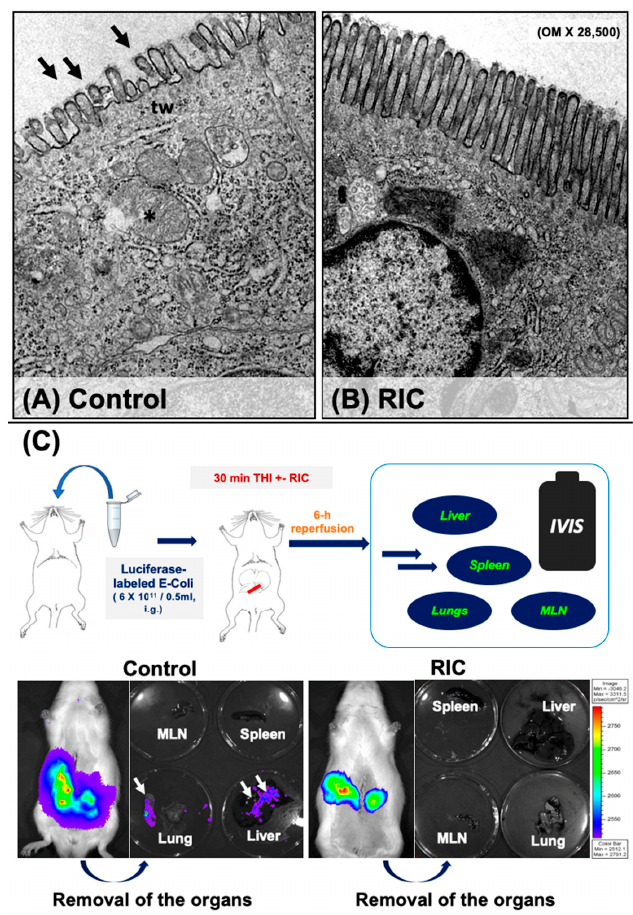
Figure 6. Ultrastructural and functional assessment of intestinal barrier integrity. Following 30-min of total hepatic ischemia and 6-h of reperfusion, electron microscopy of the ileum showed disruption of microvilli which were partially showing signs of vacuolization (arrows) as well as a disintegration of the terminal web (tw) and swollen mitochondria with partial disintegration of their membrane and cristae (asterix) in the animals of the Control group ( A ). Following iRIC, better preserved cellular ultrastructure was observed on the samples of the RIC group with almost regular microvilli and subcellular structures ( B ). To assess functional integrity of the intestinal barrier animals were treated with luciferase labelled Escherichia coli before THI ( C ). Following 30-min of ischemia and 6-h of reperfusion, bacterial translocation was assessed using an in vivo imaging system. After the retrieval of the organs these were assessed for luciferase intensity. Intestinal barrier function was better preserved following iRIC and THI. Animals receiving luciferase labelled E. coli before IRI had a markedly increased extra-intestinal luciferase activity after 6-h of reperfusion, especially in the liver and the lungs as well as in mesenterial lymph nodes in the Control group. No relevant extra-intestinal activity was observed in the animals of the RIC group. Abbreviations used: OM-original magnification; RIC-remote ischemic conditioning; THI-total hepatic ischemia; IVIS-in vivo imaging system; MLN-mesenterial lymph node.